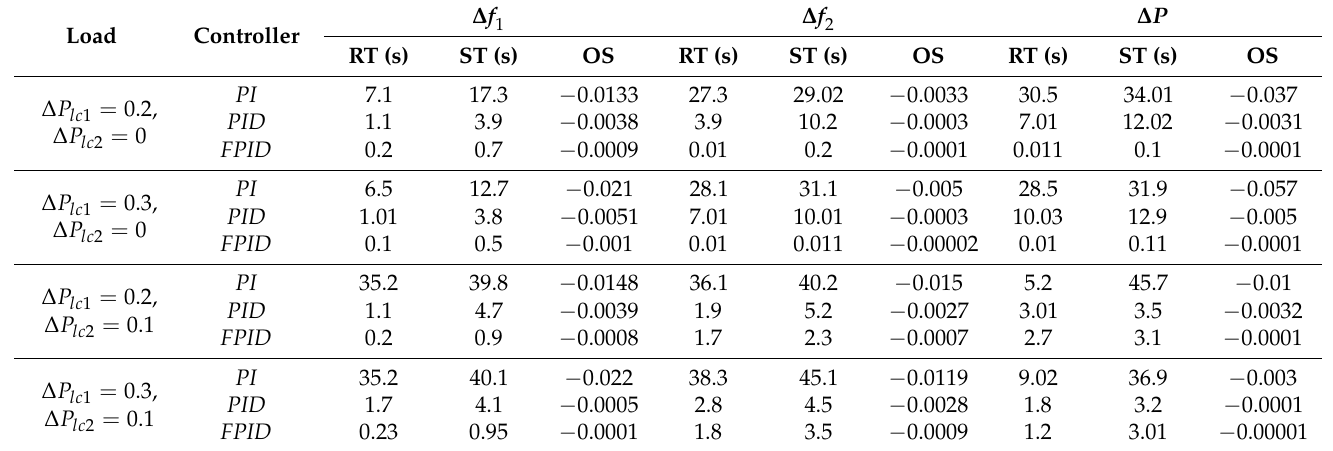
Table 6. Performance of the INPS under load change.